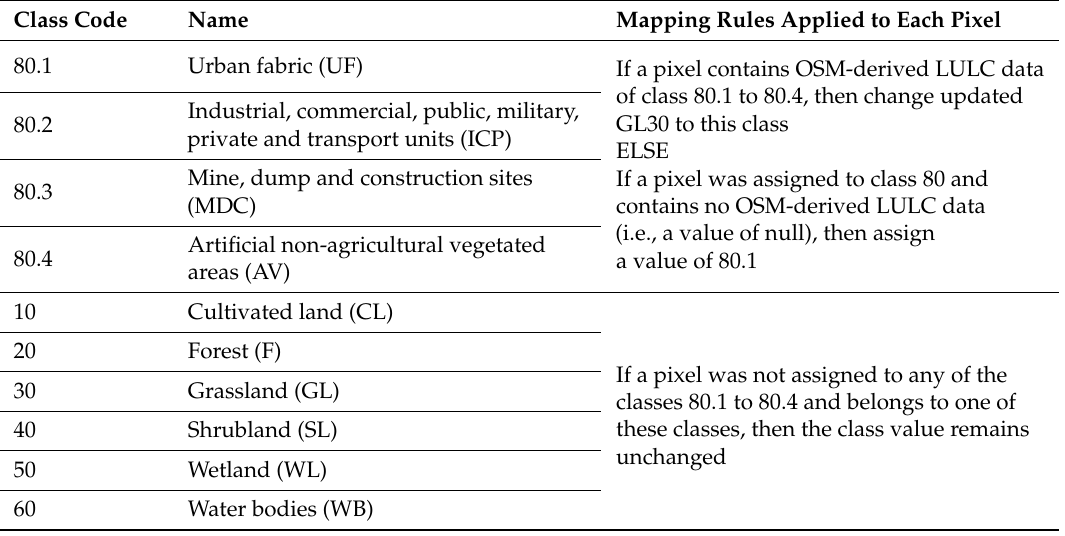
Table 4. Nomenclature used in the enhanced GL30